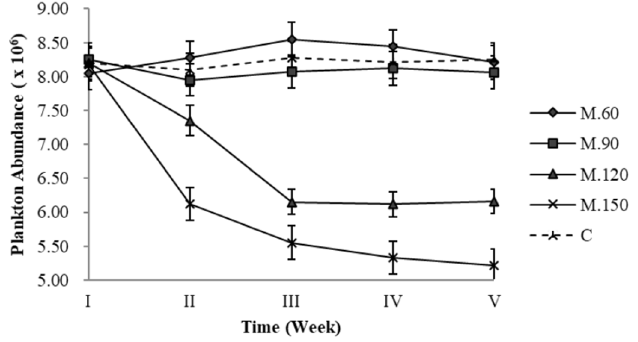
Fig. 11. The abundance of phytoplankton ( (cid:3) 10 6 ) over time in the control and at various densities of P. viridis